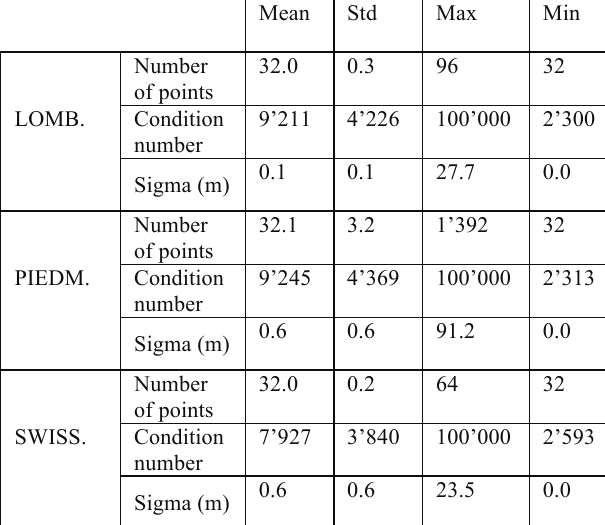
Table 4. Statistics of the results of the individual interpolation of the three low/medium resolution input DTMs on the output HD-1 grid, before the average results operation (total of 22’822’816, 33’746’321, 35’699’169 real valued nodes respectively for Lombardy, Piedmont and Switzerland datasets).